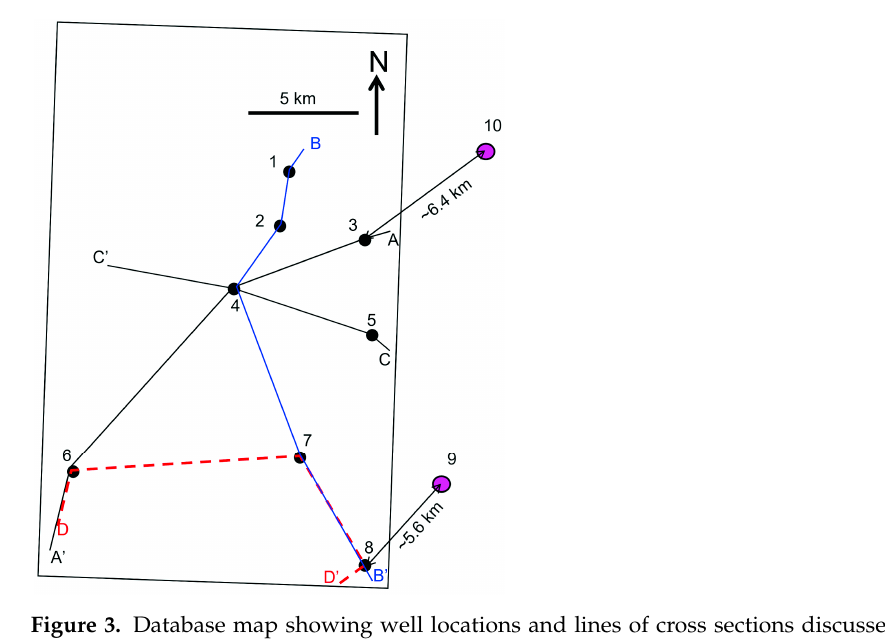
Figure 3. Database map showing well locations and lines of cross sections discussed in the text. Note: Red, black, and blue colors are used to identify different line of cross sections where lines are